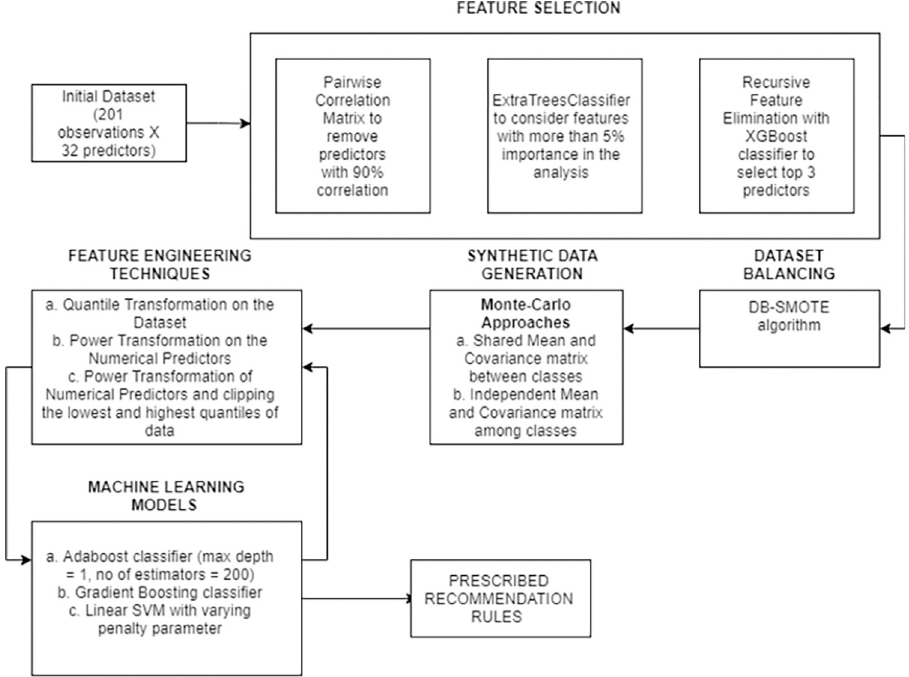
Fig 1. A pipeline of the approach used in the paper for prescribing recommendation